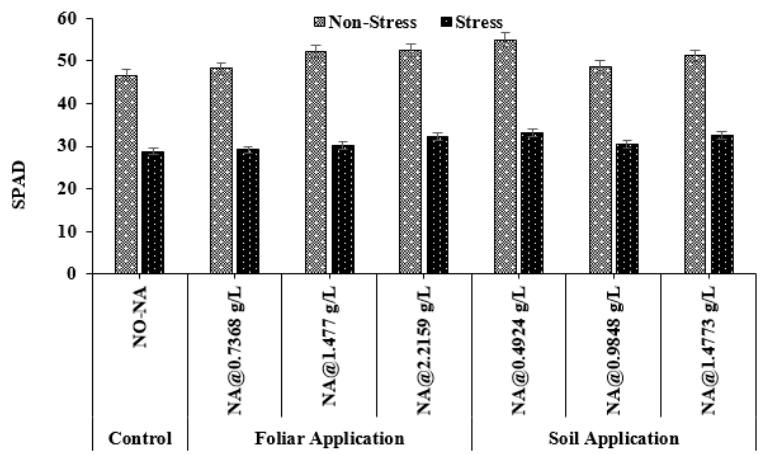
Figure 6. Effect of exogenously applied nicotinic acid on Soil Plant Analysis Development (SPAD) at the anthesis stage of the plant under control and water deficit stress levels.